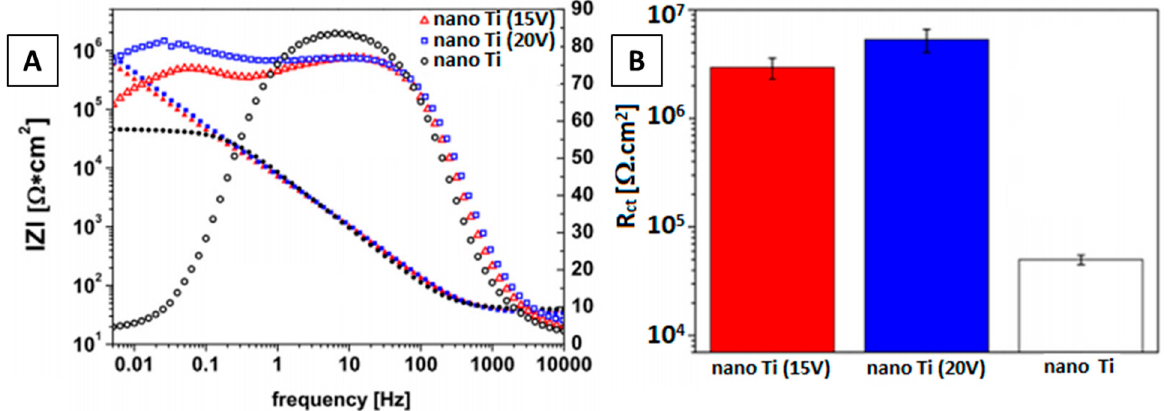
Figure 11. ( A ) EIS spectra of chi/BG-coated and uncoated Ti, ( B ) charge transfer resistance chart for coated and uncoated Ti. Reproduced from [81] with permission from Elsevier™.